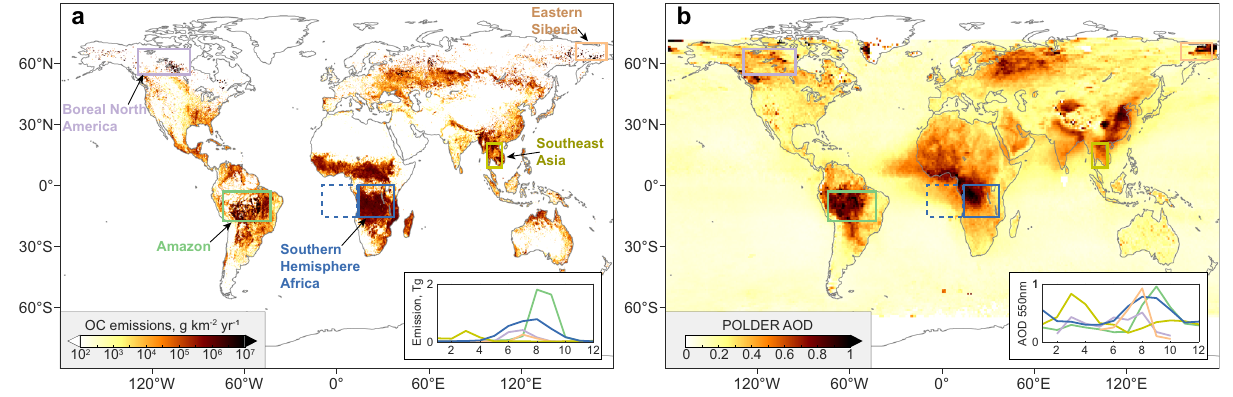
Fig. 1 | Geophysical distribution of biomass burning emissions and aerosol optical depth (AOD) in 2010. a Annual organic carbon (OC) emissions based on GFED (https://www.global fi redata.org) 35 . b Annual mean AOD at 550nm from POLDER satellite observation (https://www.grasp-open.com) 43 . The boxes indicate the spatial coverage of the fi ve key biomass burning regions focused on here. The